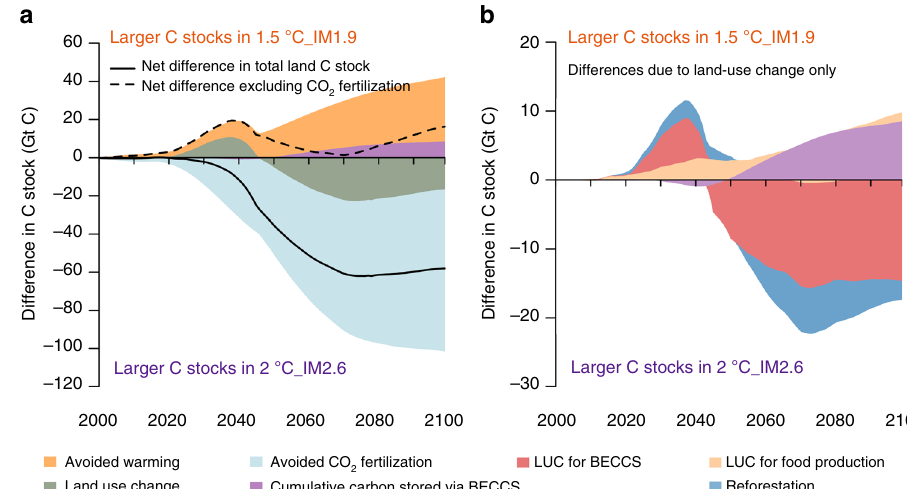
Fig. 5 Attribution of differences in land carbon stocks between scenarios based on JULES model simulations. a The net difference (sum of C veg + C soil + geologically stored CO 2 from BECCS) and each component between 1.5 °C_IM1.9 and 2 °C_IM2.6. Positive values indicate larger land carbon stocks in 1.5 °C_IM1.9. b The drivers of the land use change effect. Total LUC effect (olive green in panel a ) can be attributed to LUC for: food production (crop and pasture), BECCS, and land abandonment/reforestation. These are shown with the cumulative carbon removed via BECCS for